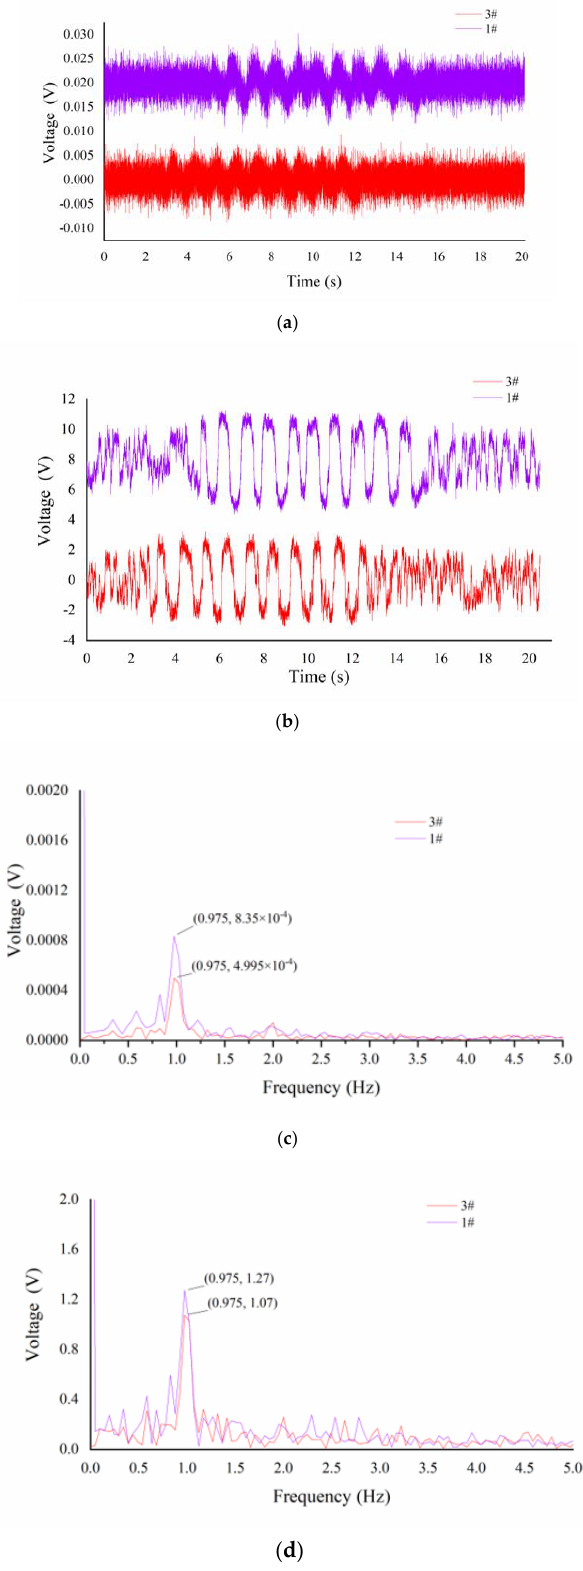
Figure 8. Diagram of output signal for sample S31 (v = 2 mm/s): ( a ) original signal processed by de-baseline method; ( b ) signal processed by SR model; ( c ) original frequency-domain signal; ( d ) SR-processed frequency-domain signal.